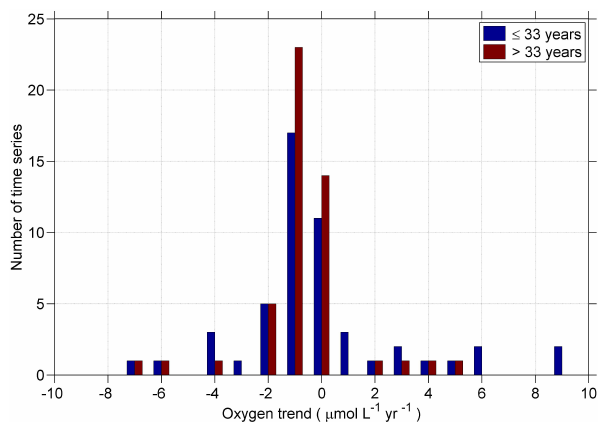
Fig. 5. Map of oxygen trends from refereed journal publications (Table 2).